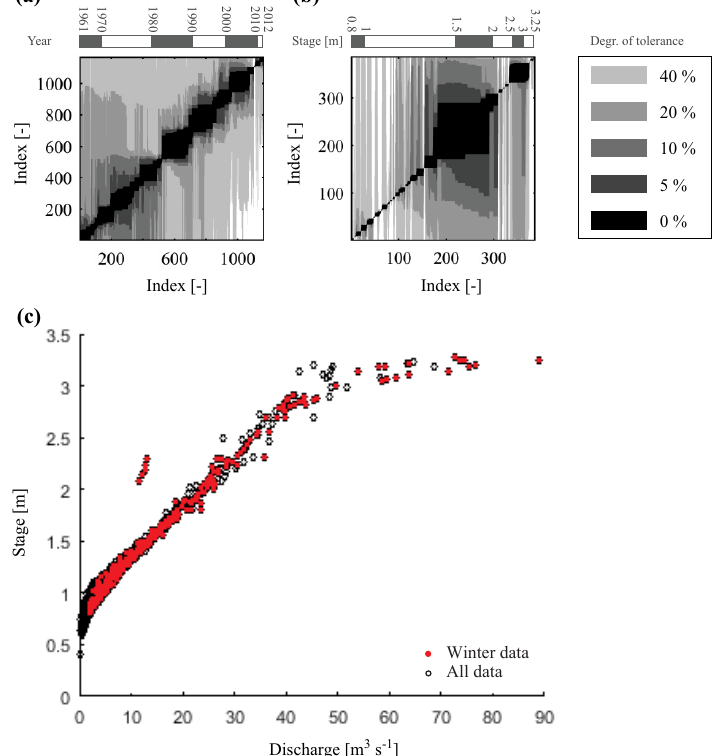
Figure 5. (a) Combined BReach t_3s plot (all data) and (b) combined BReach h_1s plot (winter data) for Clog-y-Fran. In all subplots, for each index on the x axis the gray area indicates the span between the index of the maximum left reach (under the bisector) and the maximum right reach (above the bisector). Each gray tint represents a different degree of tolerance (i.e., percentage of data points allowed to have nonacceptable model results). (c) Stage–discharge data for